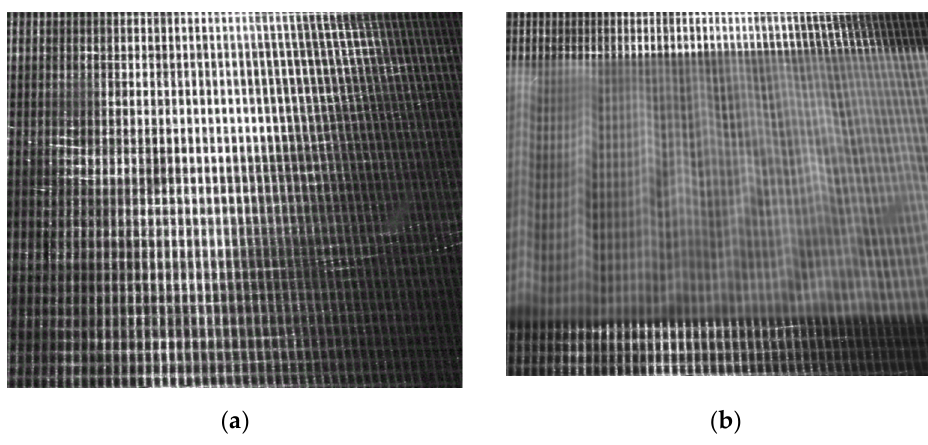
Figure 3. Typical experimental state image: ( a ) Reference image; ( b ) Experimental image.